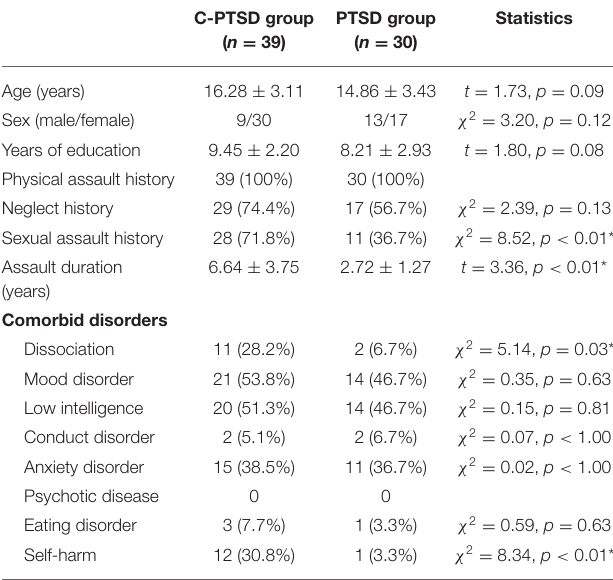
TABLE 1 | Comparison of demographic characteristics and clinical scales between the C-PTSD and PTSD groups.